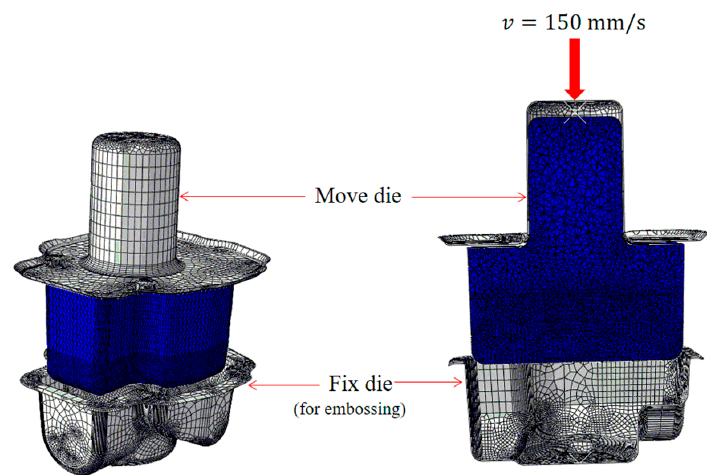
Figure 9. Boundary conditions of warm forging for embossing forming.